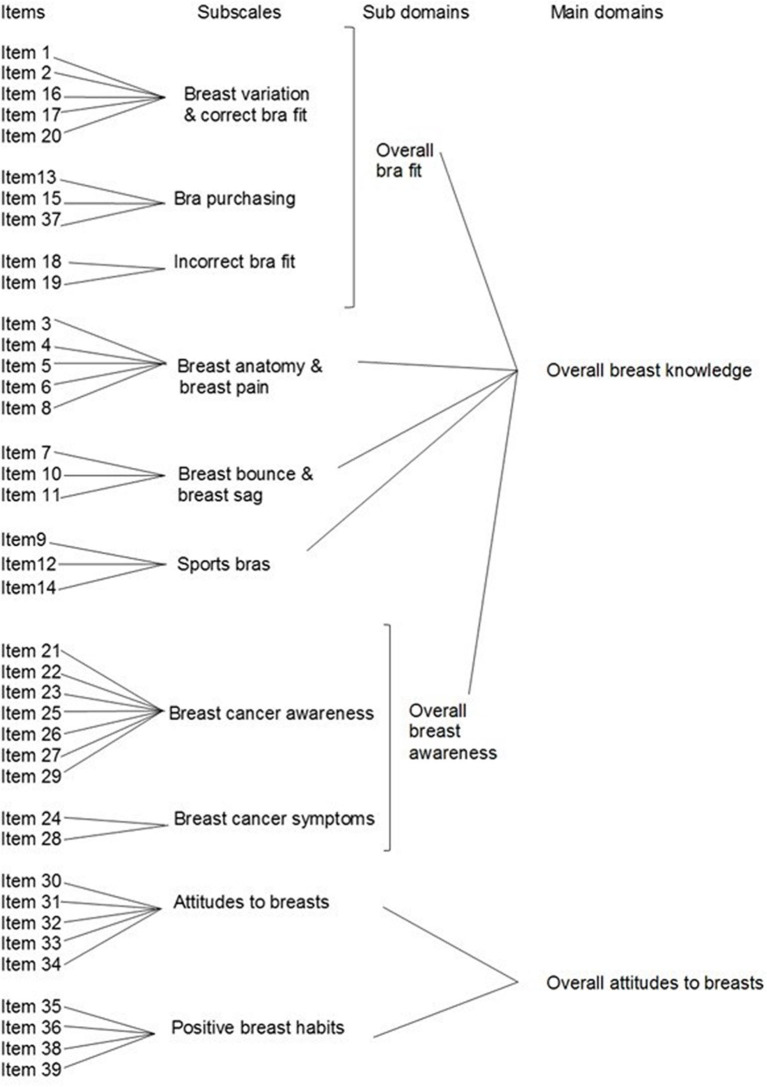
Breast survey items (n = 39), subscales (n = 10), and summary measures. The subscales are collapsed into an overall breast knowledge, overall attitudes to breasts (main domains), overall bra fit, and overall breast awareness (sub domains). *Measures breast knowledge (n: 11). †Measures attitudes to breasts and engagement with positive breast habits (n: 3).